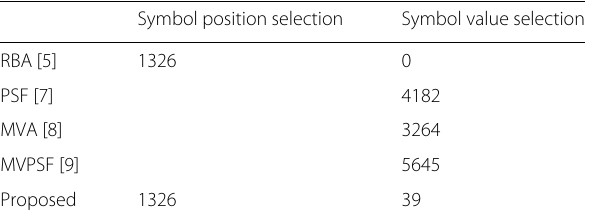
algorithm for 204 × 102, GF(4) LDPC